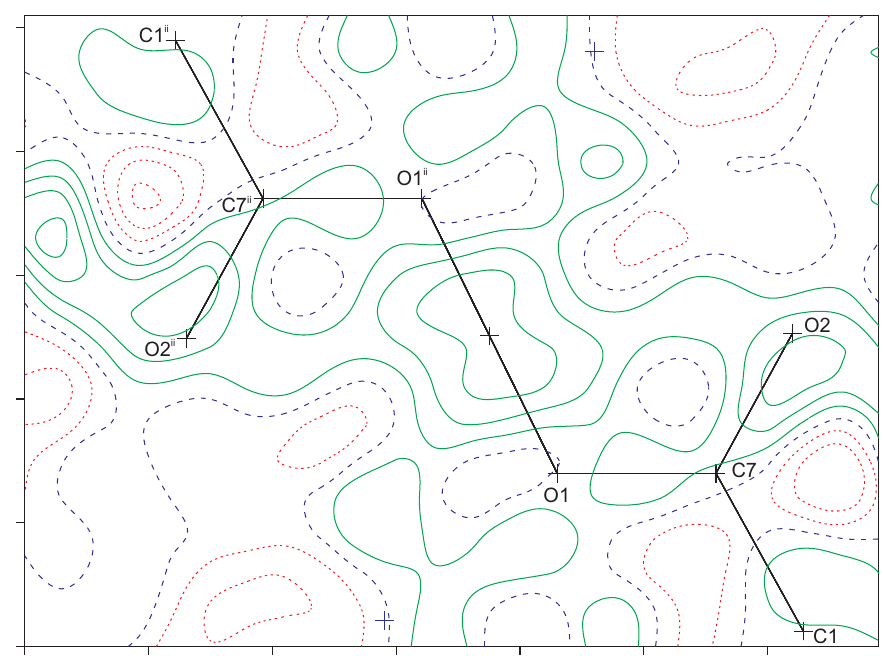
Figure 2. Difference Fourier map in the C7-O1-O1 ii plane as calculated with the PLATON software [16]. The observed structure factors F 2 o were de-twinned with SHELXL (instruction LIST 8) [19]. Hydrogen atom H1A was omitted in the calculation of F 2 c . Contour level 0.1 e/Å 3 . Positive contours are drawn in green, negative contours in red, and the zero contour in blue. Symmetry code ii : 1 − x , 2 − y , − z